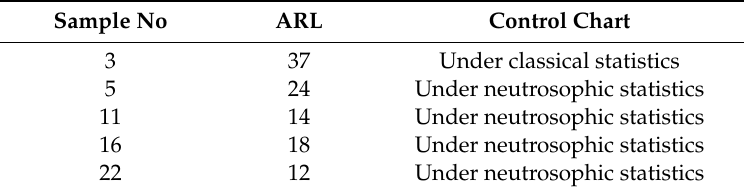
Table 5. The comparison of the proposed method with existing method when n = 25 and D =